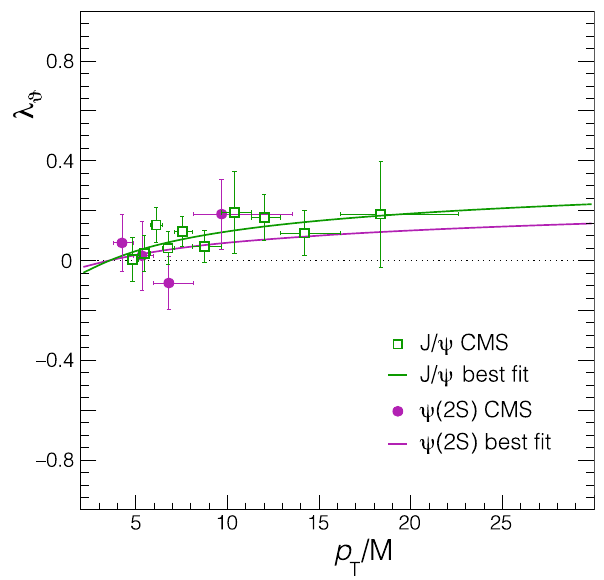
Fig. 2 Polar anisotropy parameter λ ϑ , in the helicity frame, mea- √ s = 7TeV, for prompt J /ψ and sured by CMS in pp collisions at ψ( 2S ) dimuon decays [20]. Values corresponding to two (J /ψ ) or three ( ψ( 2S ) ) rapidity bins were averaged. The curves represent the result of the fit described in the text